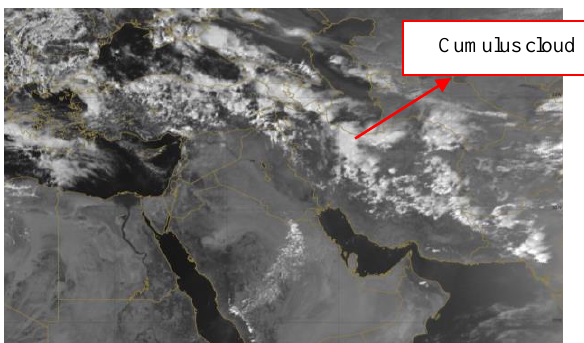
Figure 5. Cumulus cloud governing over Tehran province.